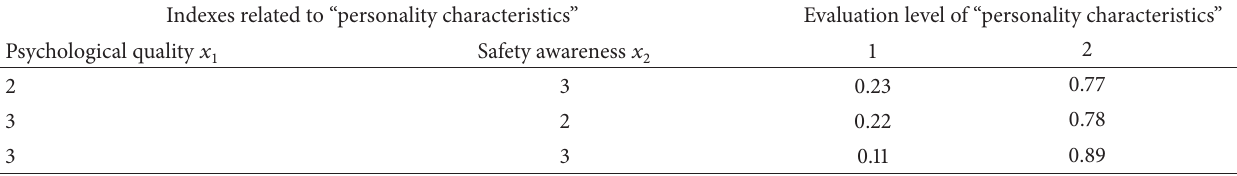
Table 6: Conditional probability of the intermediate node (personality of characteristics) beyond the historical data.